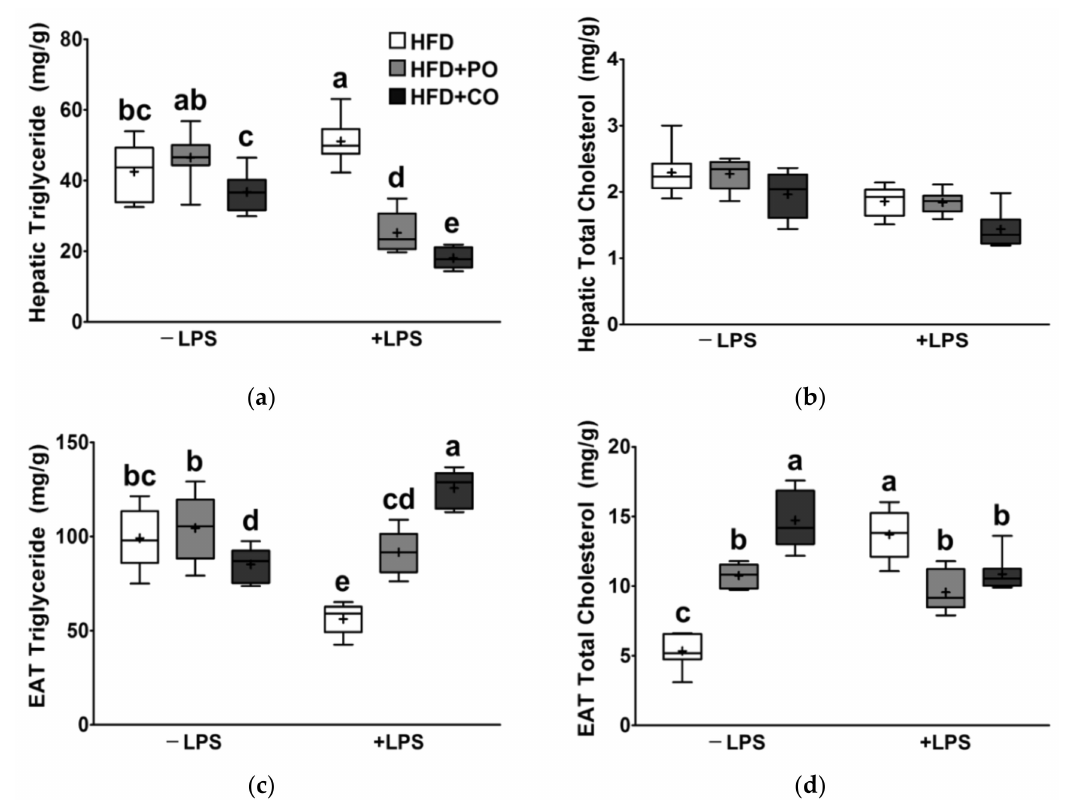
Figure 7. Effects of partial replacement of dietary fat with perilla oil or corn oil and LPS stimulation on lipid contents in liver and epididymal adipose tissue (EAT). Five-week-old male Sprague-Dawley rats were fed either the HFD, HFD + PO, or HFD + CO for 12 weeks and then treated with PBS or LPS (5 mg/kg) for 24 h ( n = 8 per group). ( a ) Hepatic TG level; ( b ) hepatic TC level; ( c ) TG level in EAT; ( d ) TC level in EAT. Data were analyzed using two-way ANOVA and Tukey’s multiple comparisons post hoc test for multiple comparisons. Means with different letters indicate significant differences at p < 0.05. LPS, lipopolysaccharide; PBS, phosphate-buffered